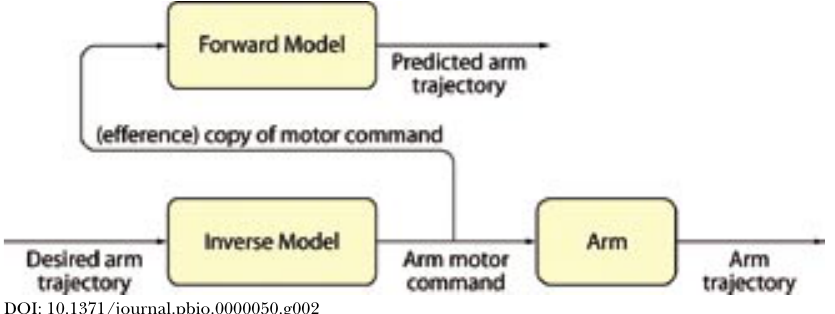
Figure 2. Internal Models in the Control of Movement The brain is hypothesized to use forward models and inverse models to control movement. Both models are subject to change based on errors that are computed by comparing predicted and actual trajectories. (Flowchart adapted from Kawato